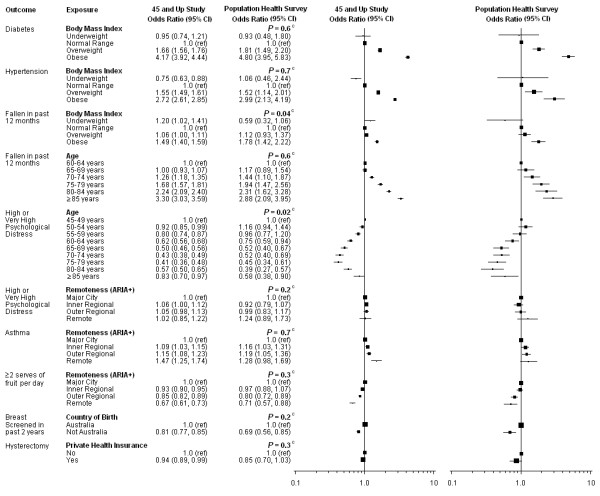
Odds ratios a by study where the exposure and outcome variables were highly comparable across the 45 and Up Study and the NSW PHS b. ARIA+, Accessibility Remoteness Index of Australia; CI, Confidence Interval; NSW, New South Wales; PHS, Population Health Survey. a Adjusting for age, sex and remoteness.
b Black squares represent ORs with area inversely proportional to the sample size contributing to the OR and the corresponding line represents the 95% confidence interval.
c P-value from Wald chi-square test: testing for a difference between the two studies for the specific exposure-outcome pair